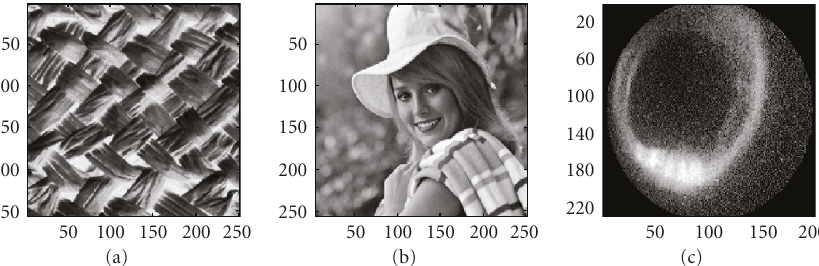
Figure 18: (a) 256 × 256-pixel region of Brodatz texture D18 [24], (b) 256 × 256-pixel Elaine image, (c) 200 × 228-pixel noisy aurora image.